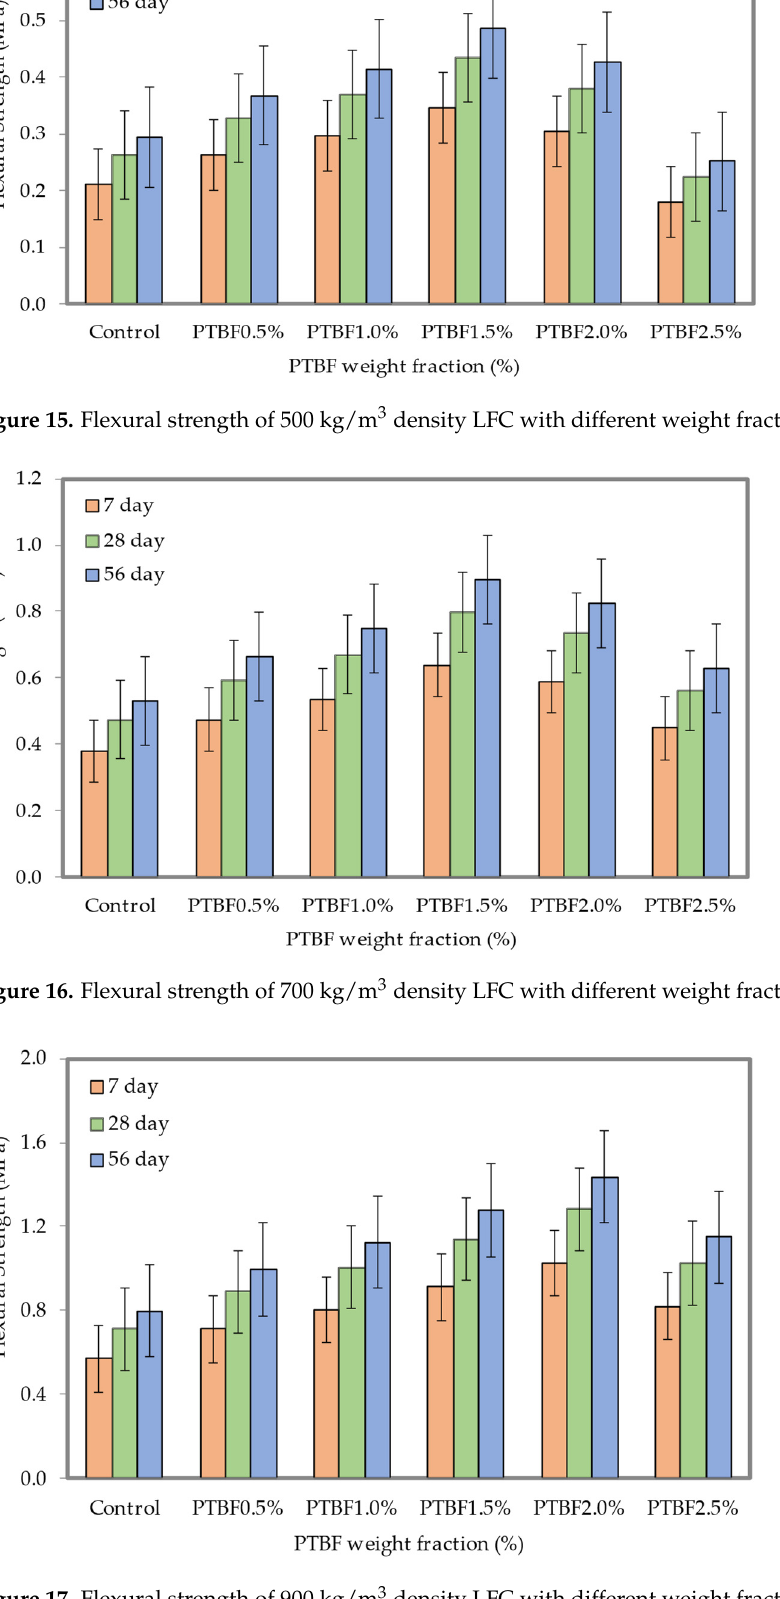
Figure 18. Tensile strength of 500 kg/m 3 density LFC with different weight fractions of PTBF. 3.7. Splitting Tensile Strength The influence of varying weight fractions of PTBF on splitting tensile strength of 500, 700 and 900 kg/m 3 densities are shown in Figures 18–20. It is noticeable from the whole trend that with the rise of PTBF weight fractions, the splitting tensile strength of entire LFC den- sities at different ages all display an upward trend. Generally, the splitting tensile strength increases steadily with the rise in the weight fractions of PTBF up to 1.5% (for densities of 500 kg/m 3 , 700 kg/m 3 ) and 2.0% (for 900 kg/m 3 density). The optimal splitting tensile strengths accomplished at day 56 were 0.30, 0.55, and 0.78 N/mm 2 , with the inclusion of a 1.5% and 2.0% weight fractions of PTBF for the 500, 700, and 900 kg/m 3 densities, respec- tively, in comparison to the control specimen, which only achieved compressive strengths of 0.18 N/mm 2 (500 kg/m 3 ), 0.34 N/mm 2 (700 kg/m 3 ), and 0.49 N/mm 2 (900 kg/m 3 ). The en- hancement of splitting tensile strengths was achieved for the three densities considered in this research because of the greater LFC robustness assisted by the existence of PTBF.